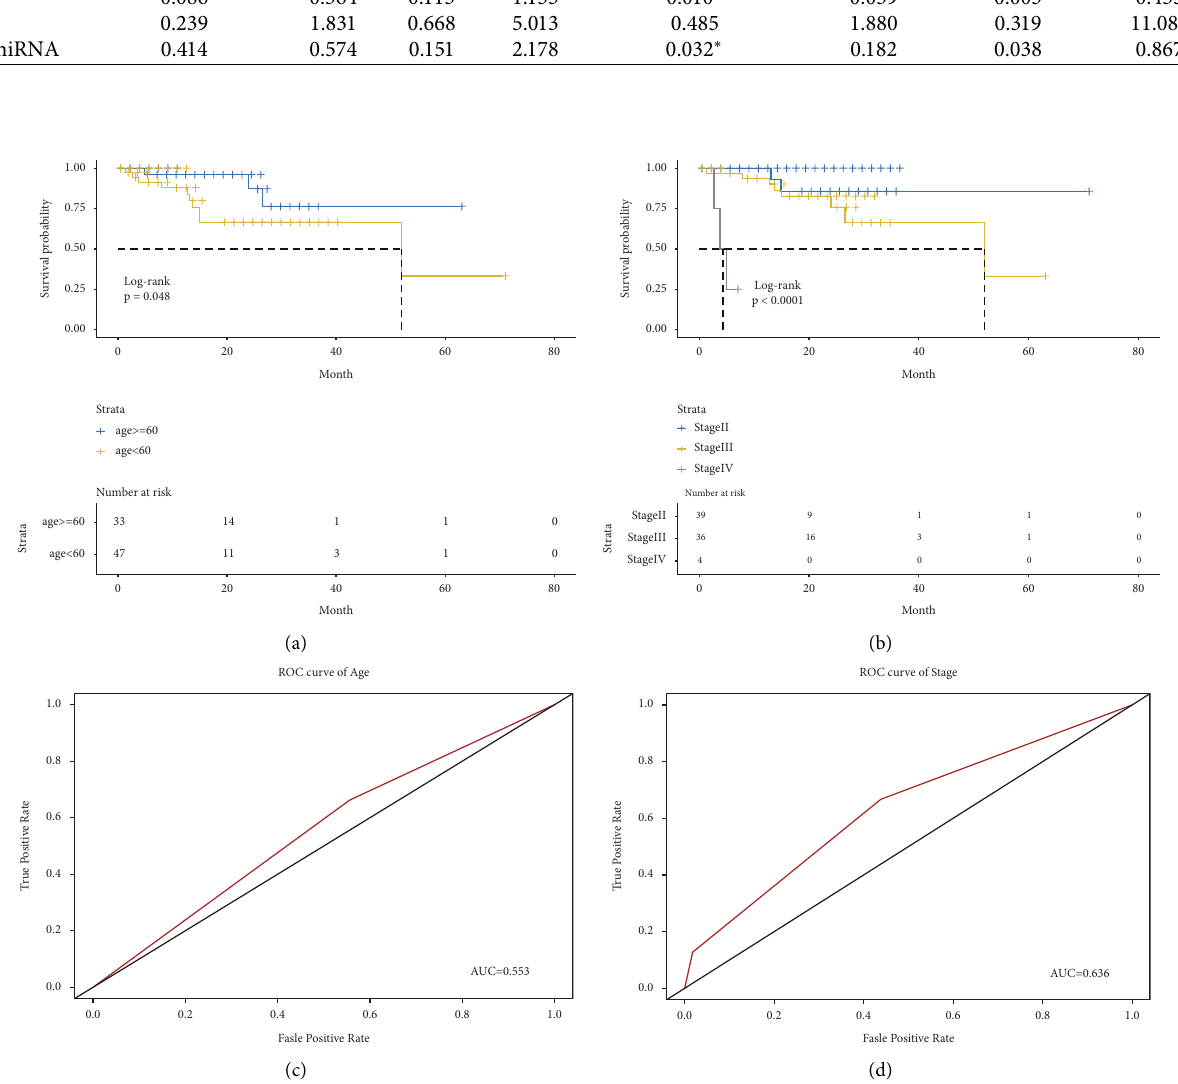
Figure 3: Kaplan–Meier survival analysis of age and stage (a, b): Kaplan–Meier survival analysis for age and stage prognostic signature of uveal melanoma (UM). (c, d): Te ROC analysis was used for the discrimination between